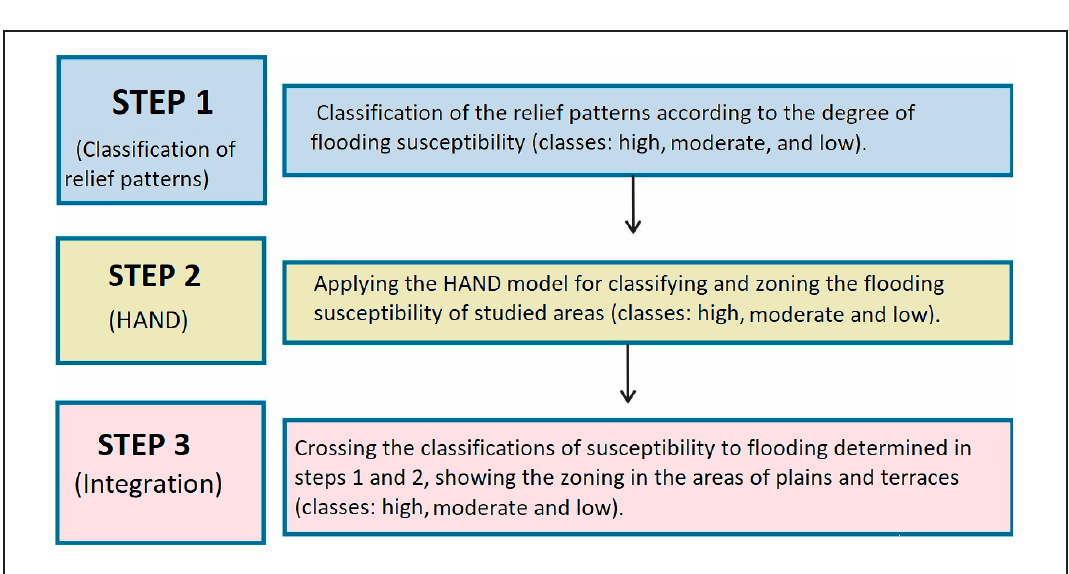
Figure 4 - Flowchart of the three basic steps performed for the analysis, classification, and zoning of flood